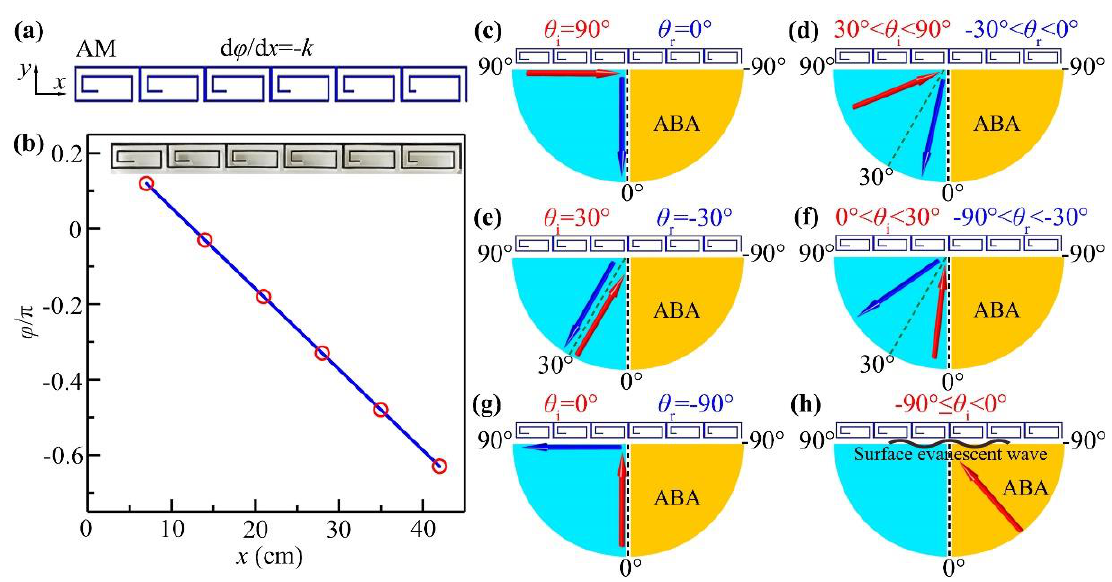
Figure 2. ( a ) Schematic of designed AM composed of 6 unit cells. ( b ) Theoretical continuous (blue solid line) and discrete (red open circles) phase delays of the AM. Schematic of theoretical propagation paths of the reflected waves (blue solid arrows) created by the AM for the incident waves (red solid arrows) with the angles ( c ) θ i = 90°, ( d ) 30° < θ i < 90°, ( e ) θ i = 30°, ( f ) 0° < θ i < 30°, ( g ) θ i = 0° and ( h ) −9 0 ° ≤ θ i < 0°.